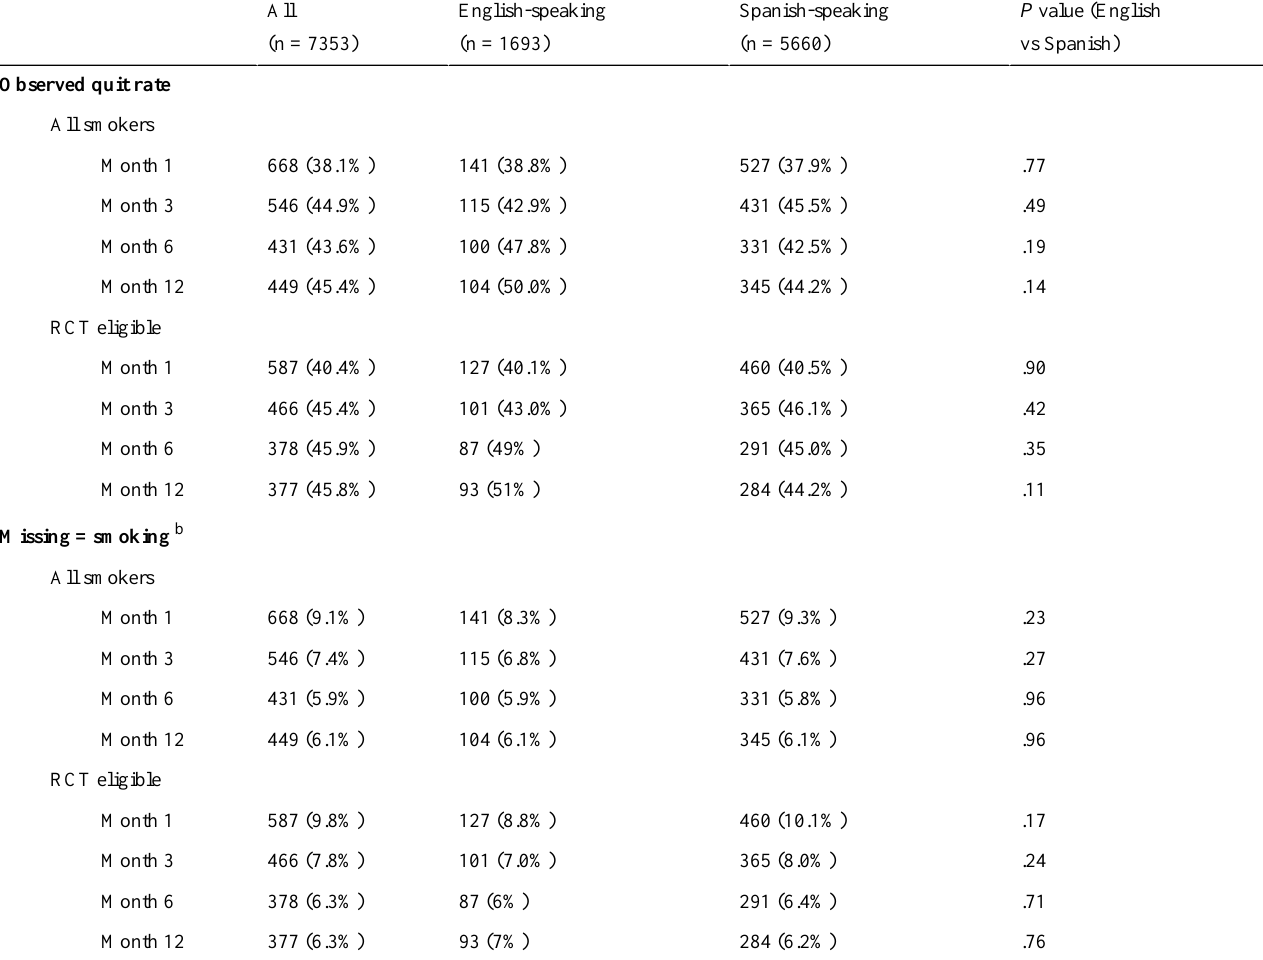
Table 3. Self-reported 7-day smoking abstinence, for all smokers and, separately, for smokers eligible for the previous RCT a (% quit).